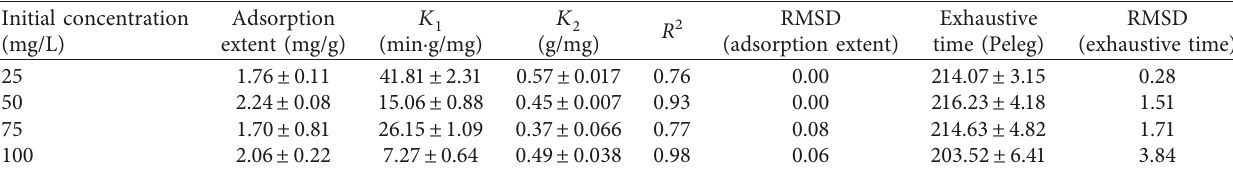
Table 5: Values of adsorption extent, Peleg’s constants ( K mean squared deviation (RMSD) at different initial concentrations.